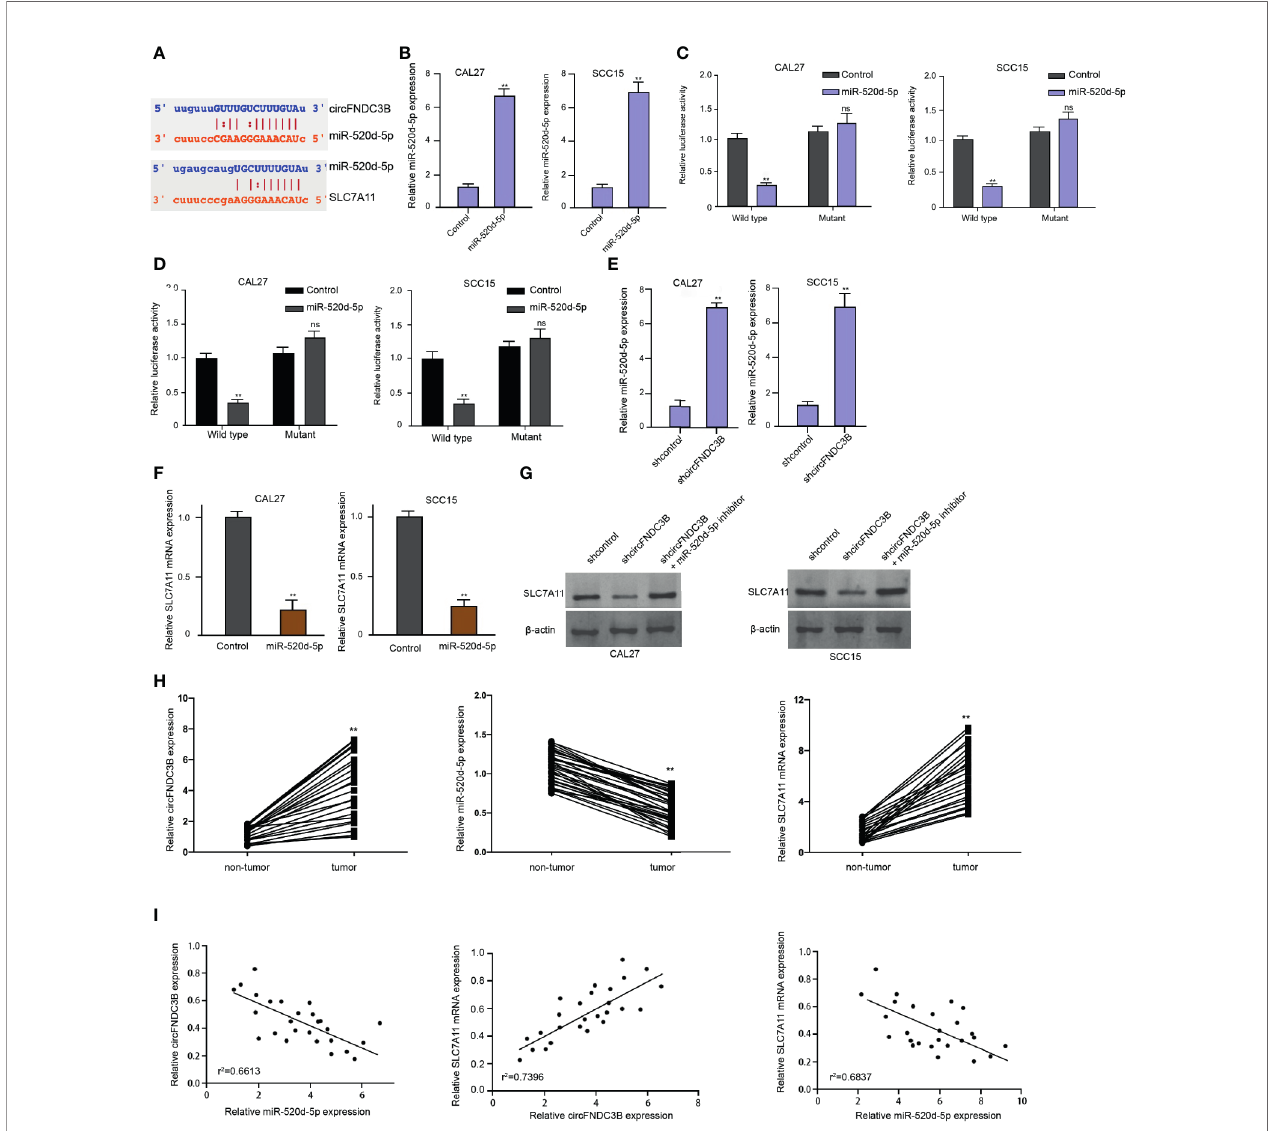
FIGURE 4 | CircFNDC3B enhances SLC7A11 expression by targeting miR-520d-5p. (A) The interaction of miR-520d-5p with circFNDC3B and SLC7A11 was identi fi ed in ENCORI online database. (B – D) MiR-520d-5p mimic or control mimic was used to treat CAL27 and SCC15 cells. (B) The RT-qPCR analysis of miR- 520d-5p expression. (C, D) Dual luciferase reporter assays of luciferase activities of circFNDC3B and SLC7A11 mRNA 3 ’ UTR, respectively. (E) The RT-qPCR analysis of miR-520d-5p expression in CAL27 and SCC15 cells treated with circFNDC3B shRNA. (F) The RT-qPCR analysis of SLC7A11 expression in CAL27 and SCC15 cells treated with miR-520d-5p mimic. (G) Western blot analysis of SLC7A11 expression in CAL27 and SCC15 cells treated with circFNDC3B shRNA and miR-520d-5p inhibitor. N = 6, mean ± SEM: ns no signi fi cance, ** P < 0.01. (H) The expression of circFNDC3B, SLC7A11, and miR-520d-5p was analyzed by qPCR in the clinical OSCC tissues and the related non-tumor tissues. (I) The correlation of circFNDC3B, SLC7A11, and miR-520d-5p was analyzed by qPCR in the clinical OSCC tissues. mean ± SEM: ** P <